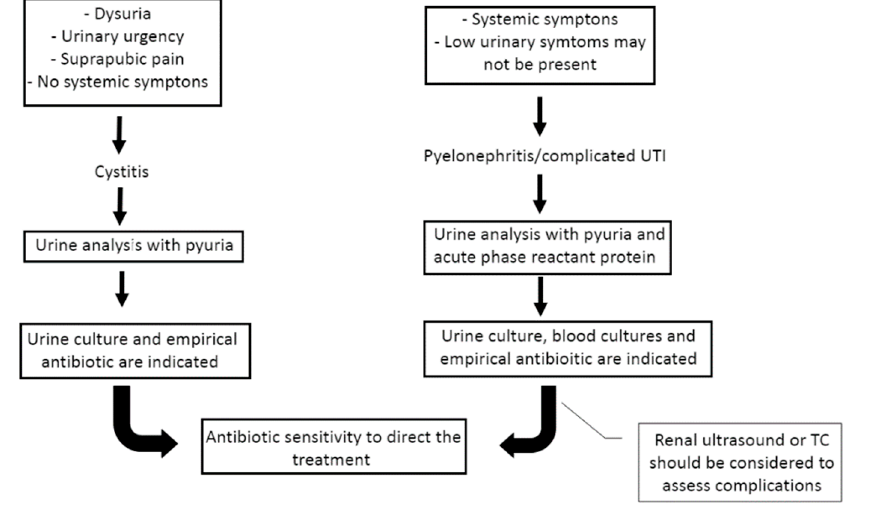
Figure 1. Diagnosis of typical urinary tract infection.